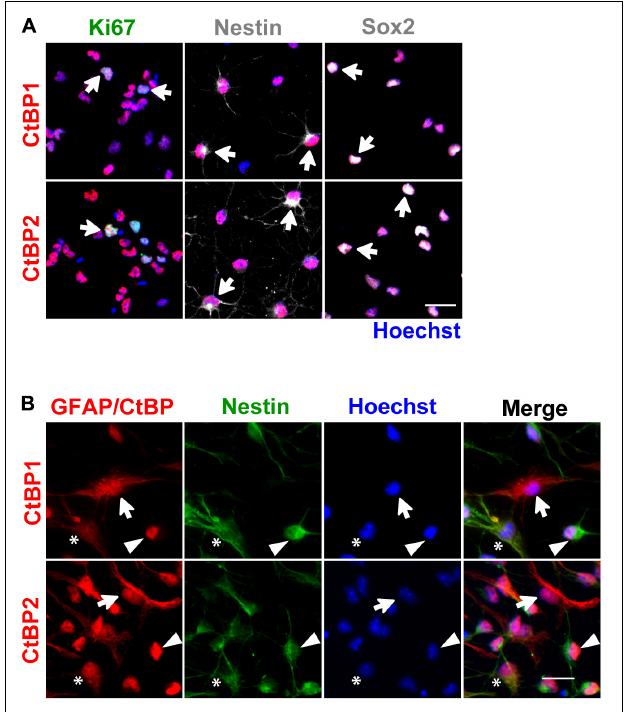
FIGURE 1 | CtBP1 and CtBP2 are expressed in immature/progenitor cells. (A) Representative confocal images of the expression of CtBPs in proliferating (Ki67) and immature cells (Nestin, Sox2), evaluated 48 h after 6-day-old neurospheres have been seeded in coverslips. (B) Representative images of the staining against CtBPs, GFAP, and Nestin, evaluated 48 h after neurospheres have been seeded in coverslips. Both CtBP1 and CtBP2 are expressed in immature Nestin + GFAP + (asterisks) and Nestin + GFAP − (arrowheads) cells and astroglial Nestin − GFAP + (arrows) cells. Nuclei are shown in blue (Hoechst staining). Scale bar: 20 µ